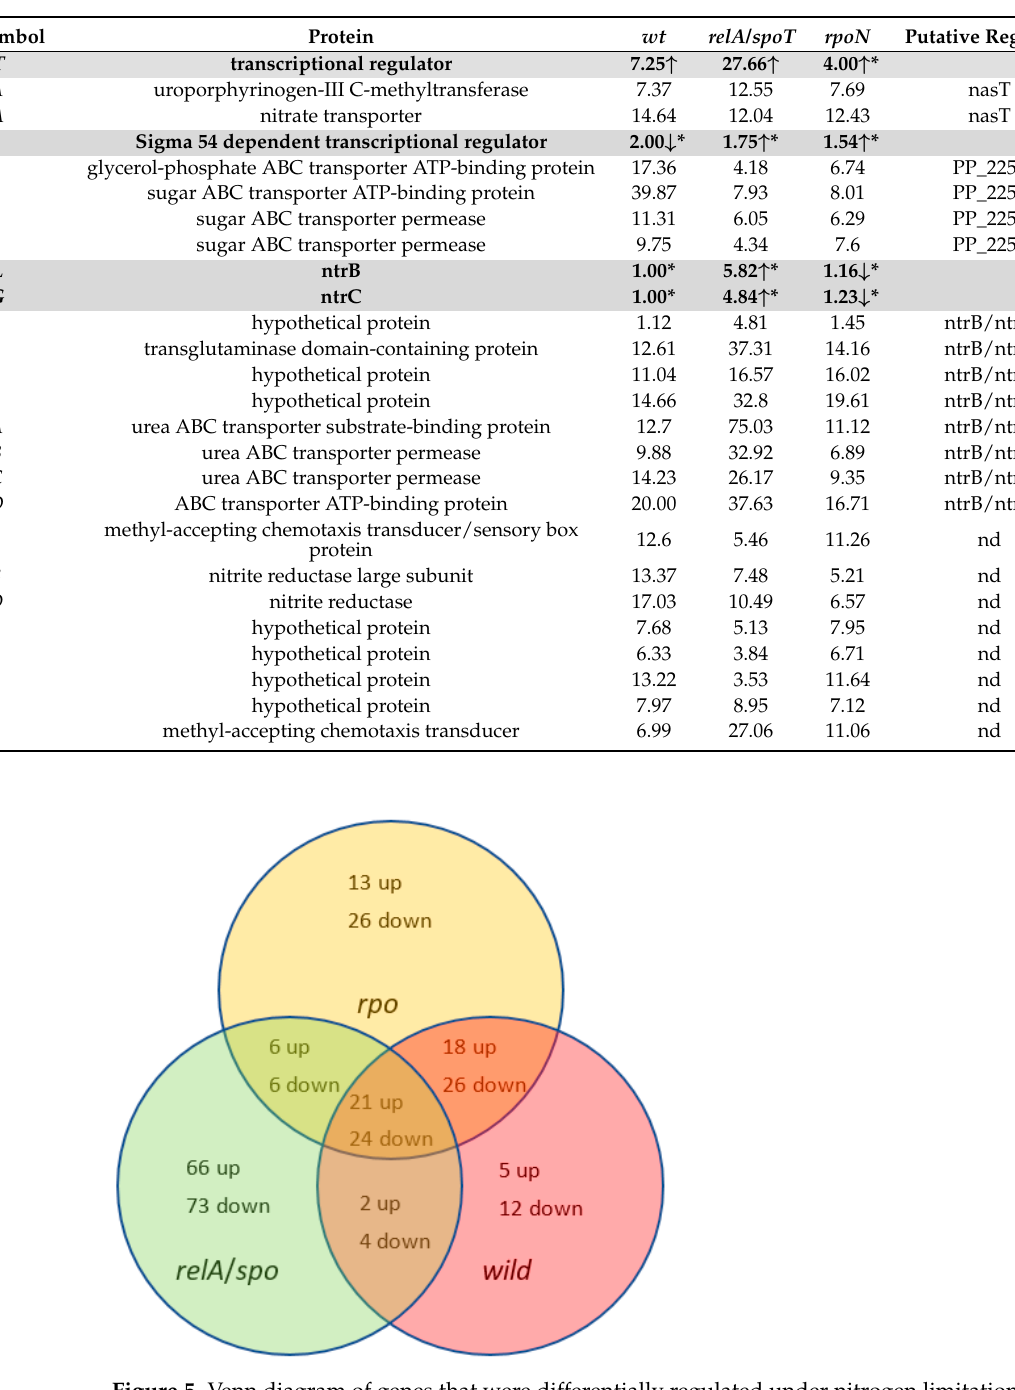
Table 2. List of genes showing statistically significant upregulation detected in all analyzed strains as a result of nitrogen limitation. The values of fold change are given below strains names. wt — P. putida KT2440, relA/spoT — P. putida KT2440 relA/spot mutant, rpoN — P. putida KT2440 rpoN mutant. The putative regulators of genes showing statistically significant differences in expression are given in grey fields. nd—not determined, *—difference statistically not significant.